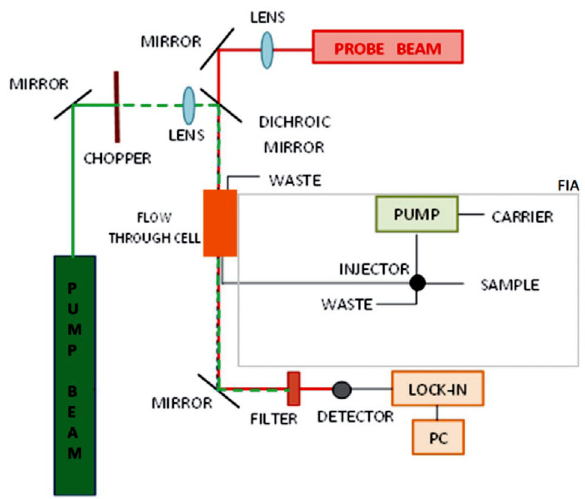
Figure 1. Scheme of the FIA-TLS experimental setup adopted from [20]